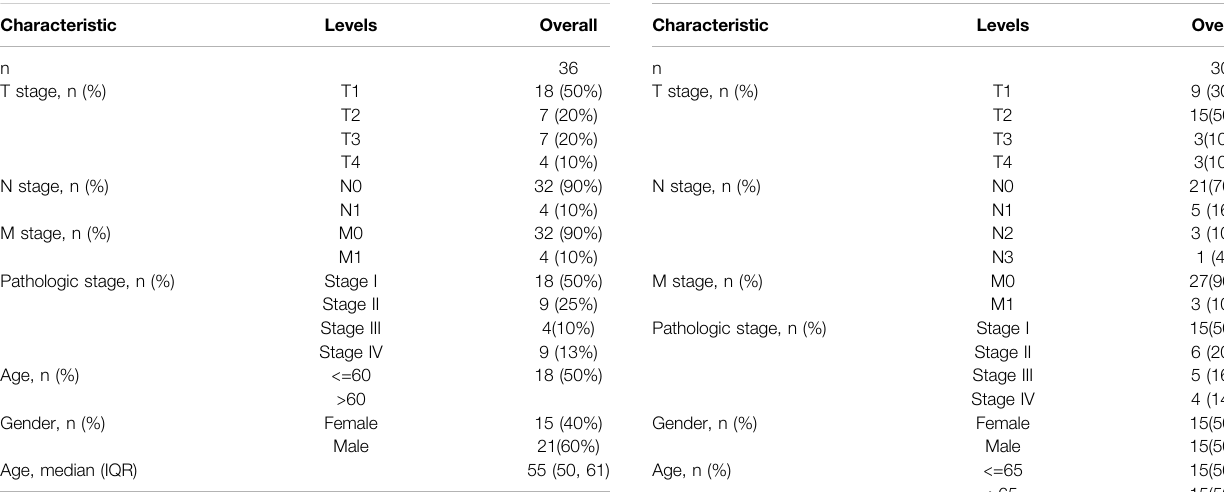
TABLE 1 | Basic clinical characteristics of LIHC patients in validation cohort. TABLE 2 | Basic clinical characteristics of LUAD patients in validation cohort.